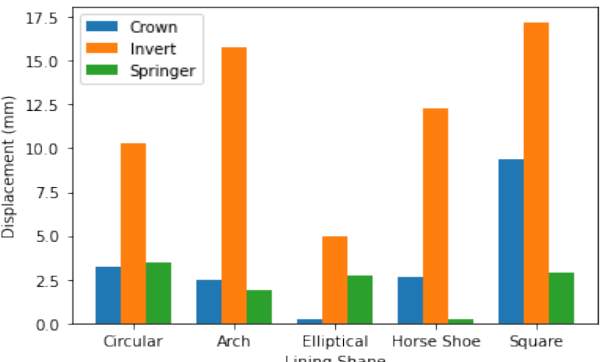
Figure 16. Vertical displacement at crucial tunnel locations.